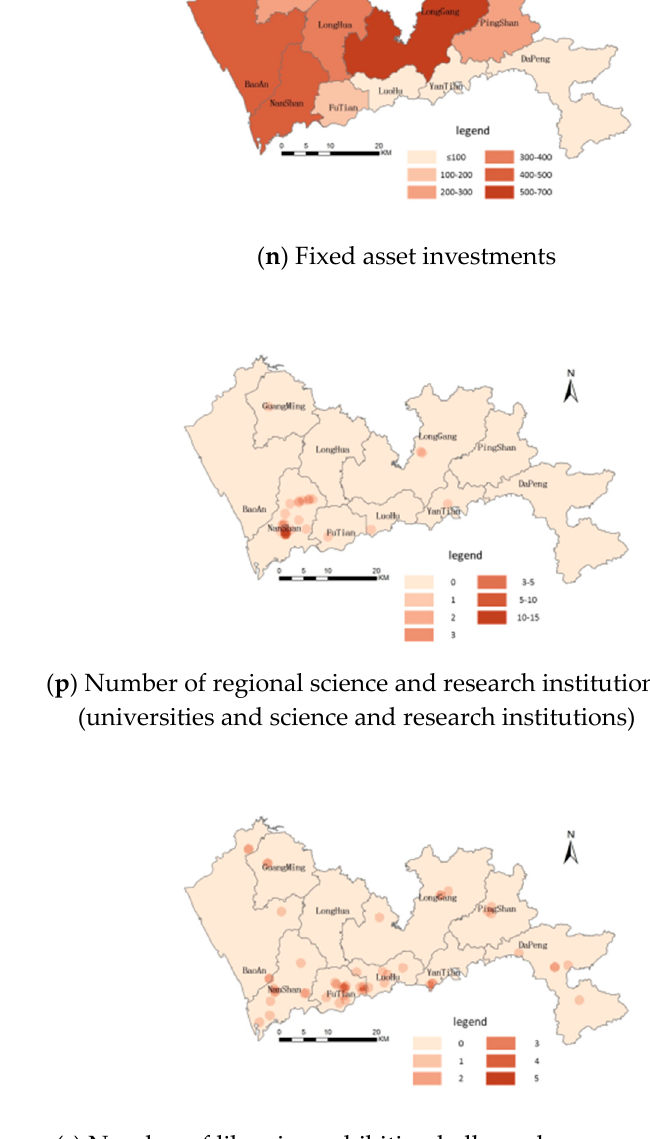
Figure A1. Grid maps of the independent